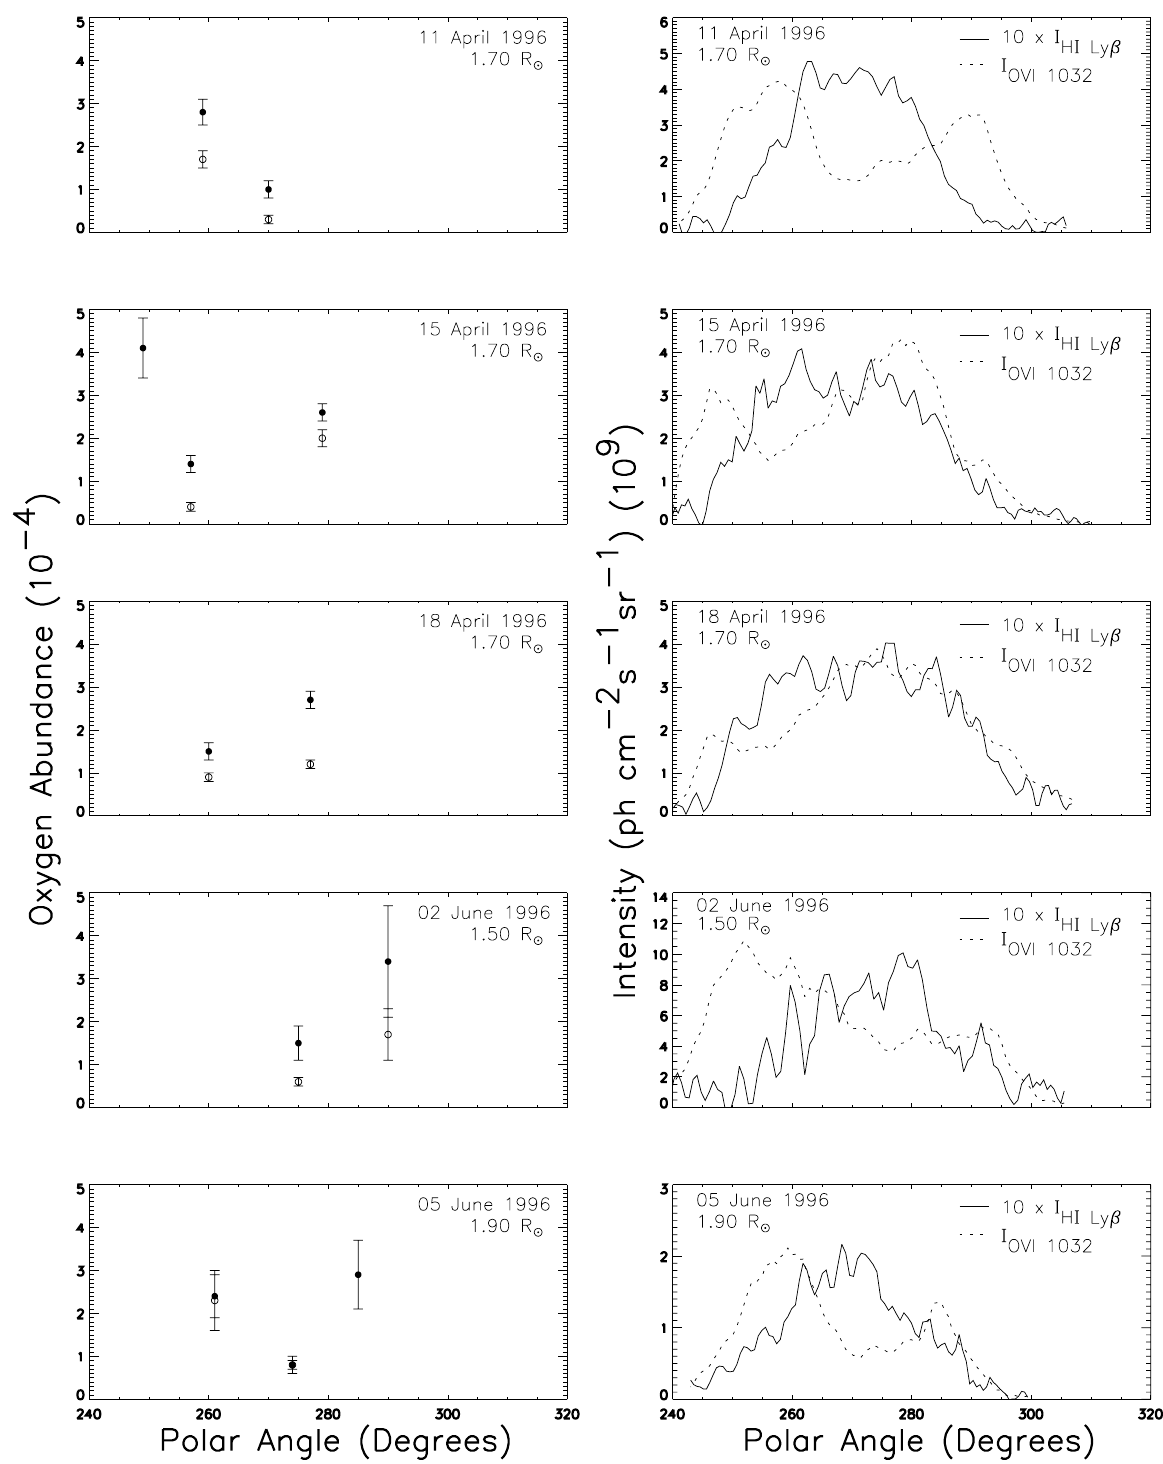
Fig. 3. In the left panels the oxygen abundance relative to hydrogen (averaged over the polar angle sectors reported in Table II) are plotted as full dots and open circles when derived from the radiative and collisional components of the O VI 1032 and the H I Ly β lines, respectively. In the right panels the intensity of the O VI 1032 and the H I Ly β lines are compared to show the regions of maximum and minimum O/H relative intensity that have allowed the selection of sectors used to perform the abundance